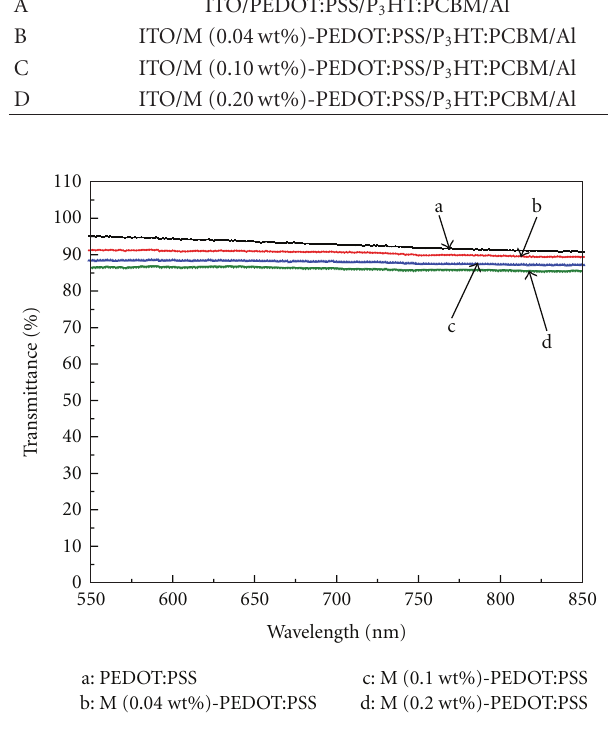
Figure 3: The optical transmittance of films as a function of weight fraction of MWCNTs.